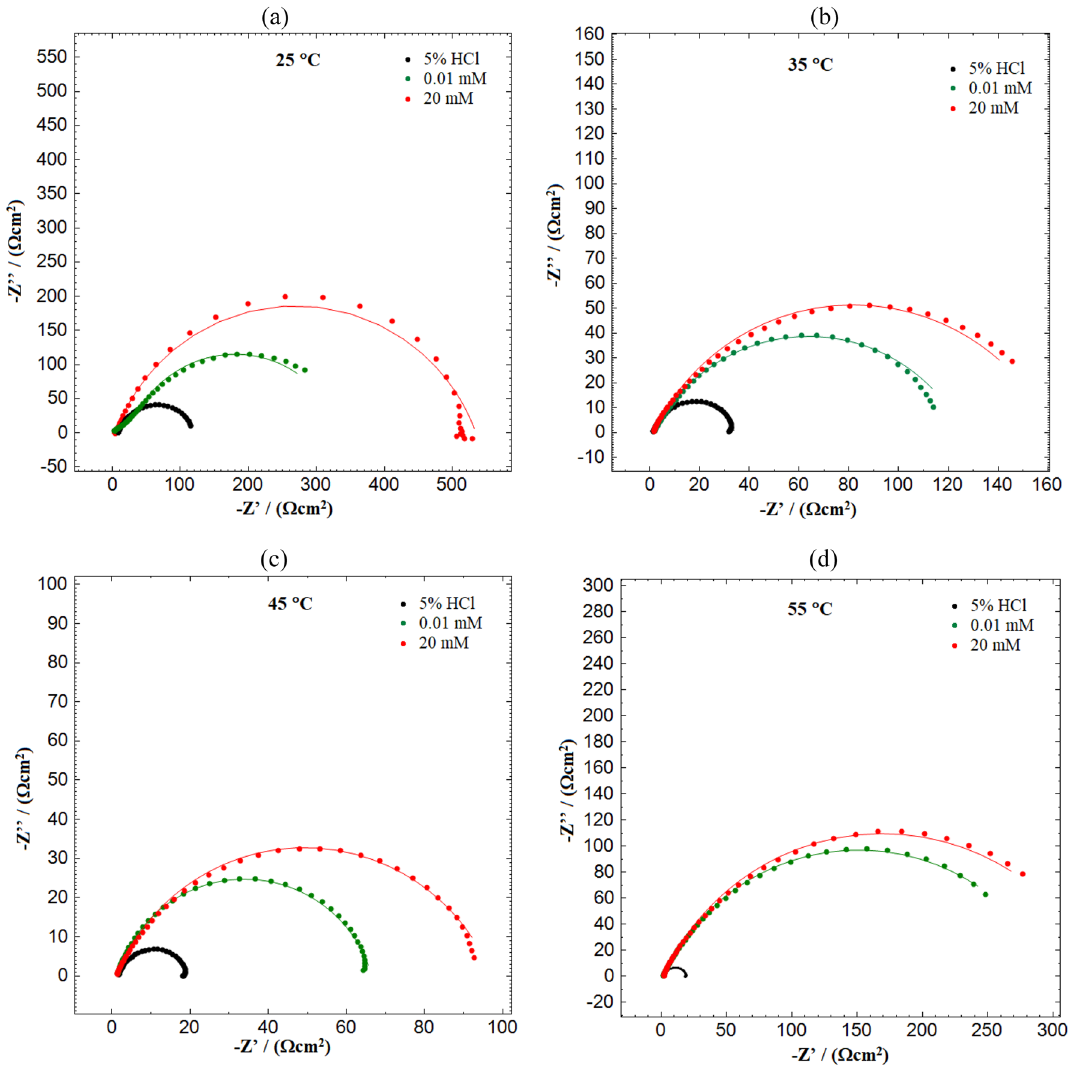
Figure 5. Nyquist plots for MS in 5% HCl solution in the absence and presence of different concentration of drug at ( a ) 25 °C, ( b ) 35 °C, ( c ) 45 °C, and ( d ) 55 °C.